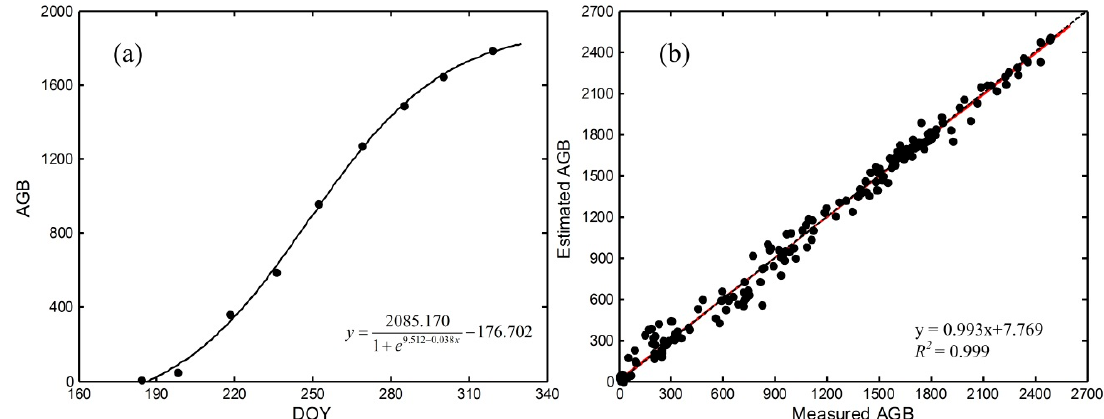
Figure 5. Dynamic curves of rice dry aboveground biomass (g/m 2 ) based on logarithmic equations: ( a ) logarithmic curve of one sample plot in 2013; ( b ) comparison of measured aboveground biomass with estimated values of all the sample plots during 2012–2013 ( n = 194). The black curve is the best-fit function for in situ AGB estimation, the black dashed line is the 45° line, and the red solid line is the linear regression trend line.